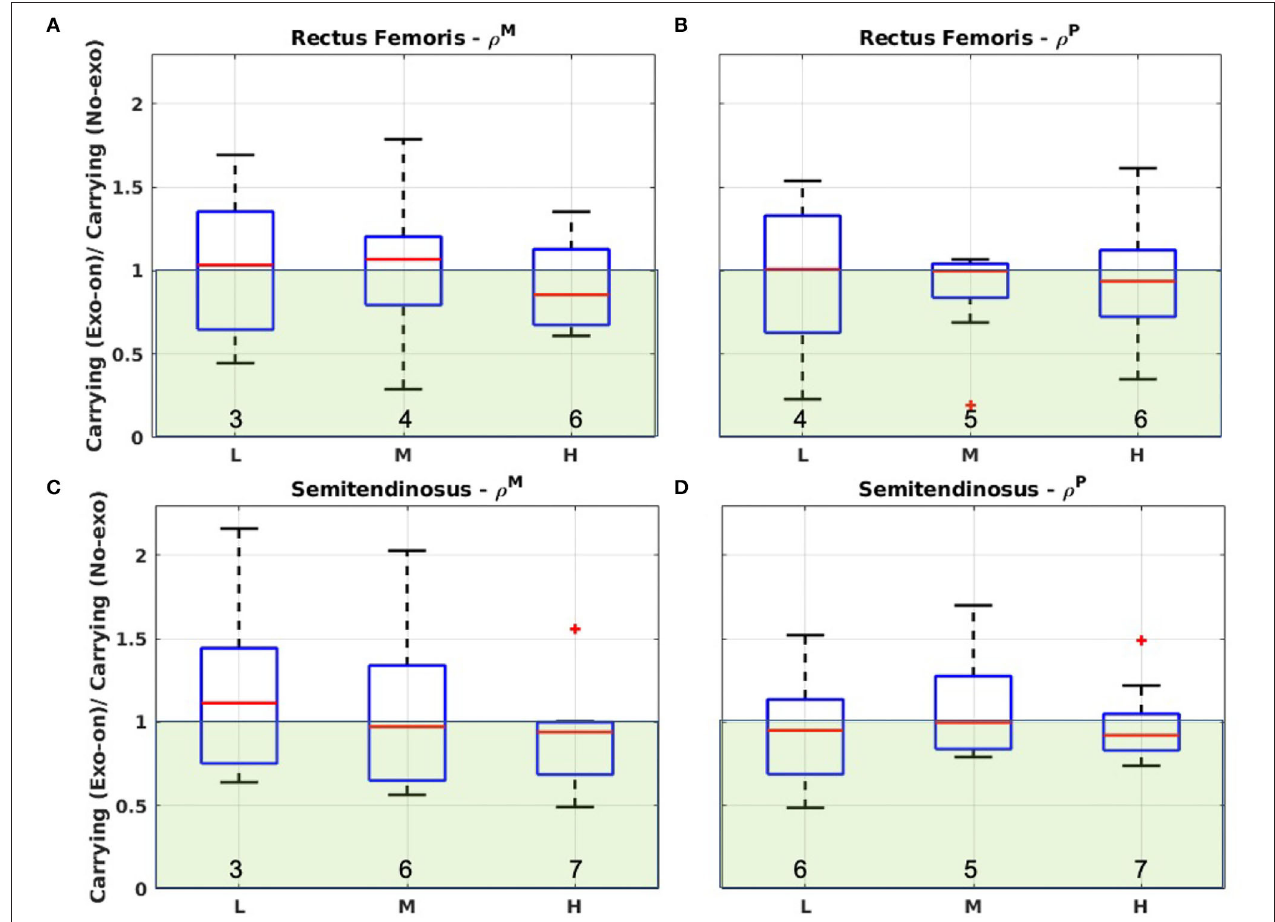
FIGURE 5 | (A) Boxplot of ρ M considering the rectus femoris activity performing carrying in Exo-on and No-exo condition. (B) Boxplot of ρ P considering the rectus femoris activity performing carrying in Exo-on and No-exo condition. (C) Boxplot of ρ M considering the semitendinosus activity performing carrying in Exo-on and No-exo condition. (D) Boxplot of ρ P considering the semitendinosus activity performing carrying in Exo-on and No-exo condition. L, M, and H refer to the light, medium, or heavy loading condition. Green-shaded areas identify the regions where ρ x i < 1 (i.e., the exoskeleton reduces the muscle activity). Numeric values at the bottom of each box report the value of γ